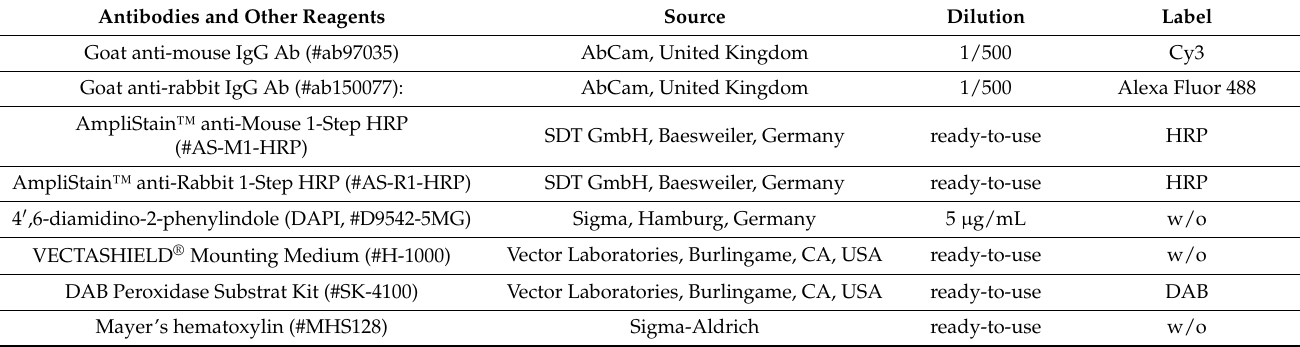
Table 3. Secondary antibodies and other